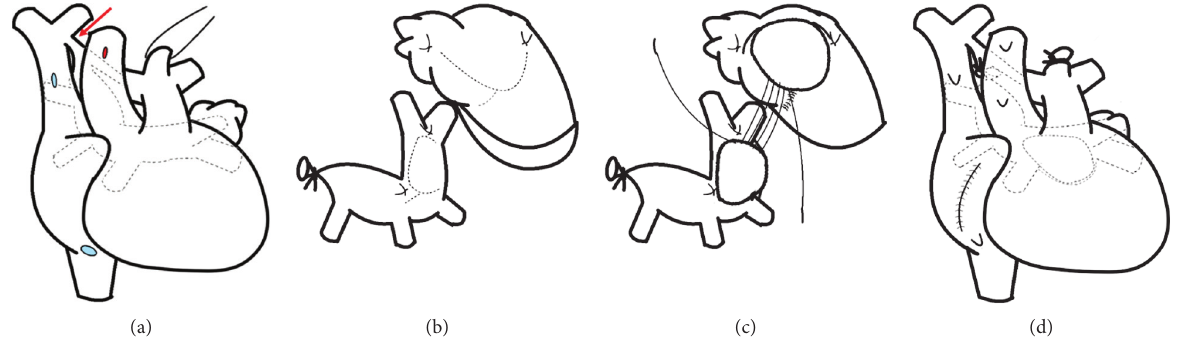
Figure 3: Details of the total anomalous pulmonary venous connection repair. (a) Overall view before surgery. The dotted line shows the pulmonary vein and common chamber. The red arrow shows the stenosis point of the vertical vein. Cardiopulmonary bypass was established with bicaval drainage (blue dots) and ascending aortic cannulation (red dot). (b) Creating the U-shaped flaps at the left atrium and common chamber. (c) Anastomosis of the left atrium and common chamber. (d) Overall view after surgery.